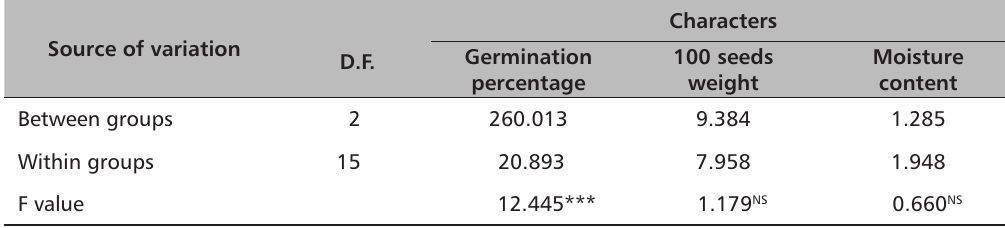
TABLE 2. Analysis of variance of tree ages factor